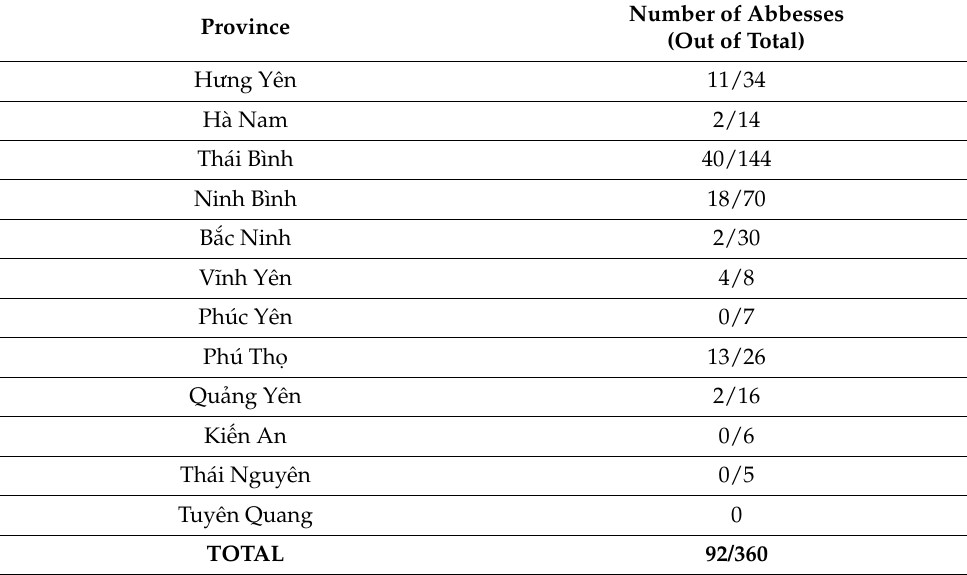
Table 1. The number of nuns who were abbess of their temple in